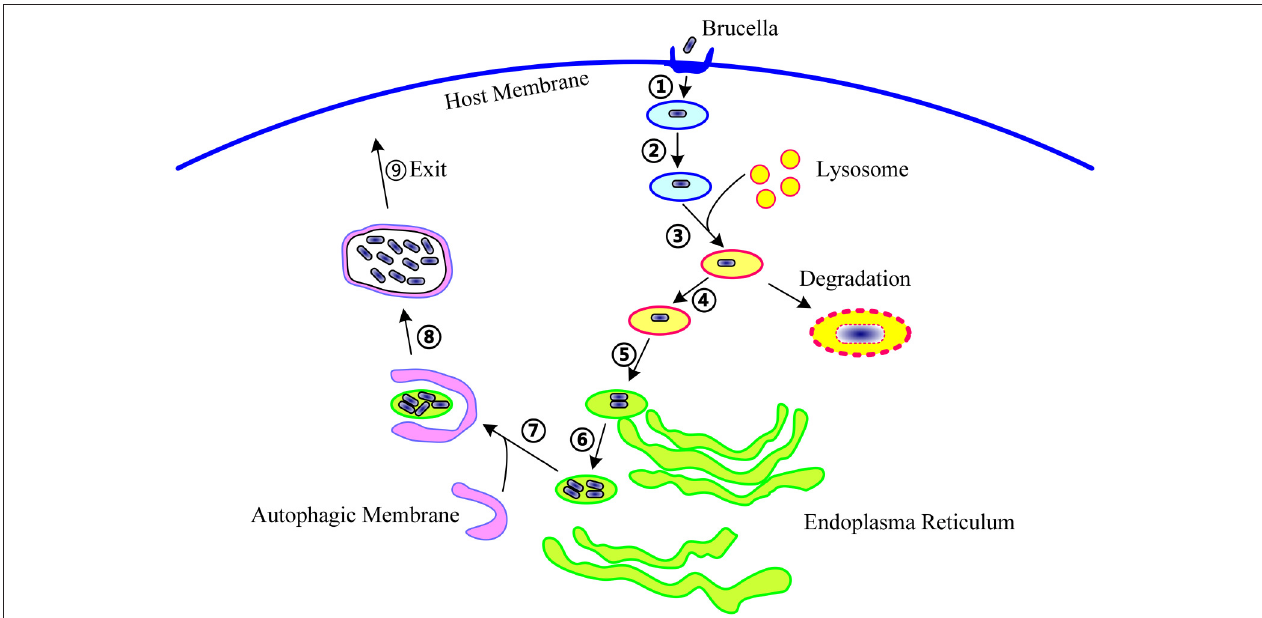
FIGURE 1 | The life cycle of Brucella within host cells. During infection, Brucella first invade the host cells ( ¬ ), form Brucella -containing vacuoles (BCVs) ( ), and undergo fusion with the lysosome in a controlled manner ( ® ). In this step, about 90% of the Brucella are degraded, and the remaining 10% survive ( ¯ ). Then, the BCV traffic to and reach the endoplasmic reticulum (ER) ( ° ), and establish the replicative site ( ± ). After ER replication, the Brucella traffic toward the autophagy-like vacuoles ( ² ), survive within these compartments ( ³ ), and finally, leave the host cells to promote cell-to-cell spreading ( ´ ). The following molecular events involved in these steps are potentially targeted by T4SS: excluding markers of the late endosome or lysosome, acquiring ER markers, interacting with secretory pathways, acquiring markers for autophagosomes, resisting the harsh intracellular environment, and regulating the activation of vital immune pathways.